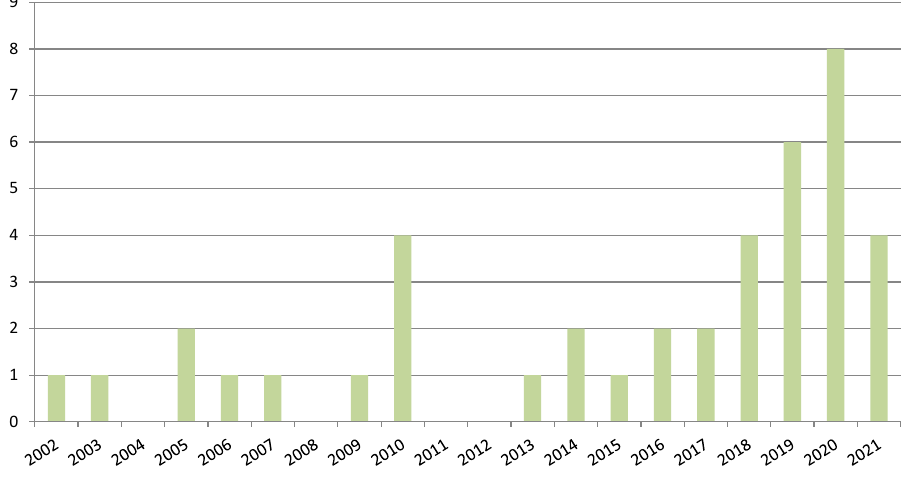
( b ) Figure 4. ( a ) Network visualization of keyword occurrence. ( b ) Network overlay of keyword oc- currence. Note: Circles represent keywords and their size represents the keywords’ importance. Clusters are identified by circles sharing the same color and the thickness of the link connecting the circles corresponds to the number of times two connected nodes are mentioned together. An earlier time is represented by a color closer to blue and a more recent year by a color closer to yel- low.